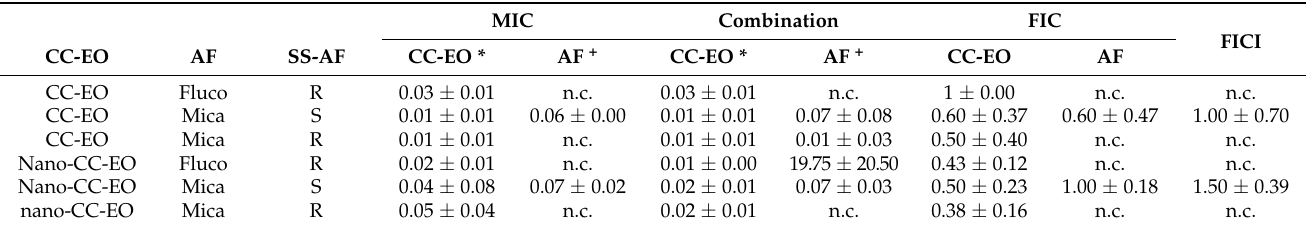
Table 5. Checkerboard titration test between free and nano-incapsulated CC-EO and Fluconazole or Micafungin.